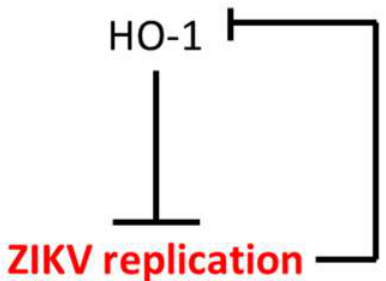
Figure 5. The model of the crosstalk between HO-1 and ZIKV. HO-1 induction inhibits ZIKV at the replication level. ZIKV growth downregulates HO-1 level through its own replication.